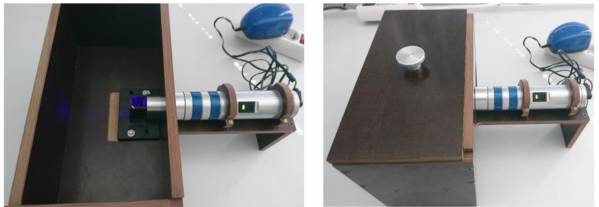
Figure 4. Illumination setup for the detection of singlet oxygen and photostability studies. The light source used is an LED-based source of violet light at 411 nm, with interchangeable fluence rates (3.5, 7, and 11 mW/cm 2 ).